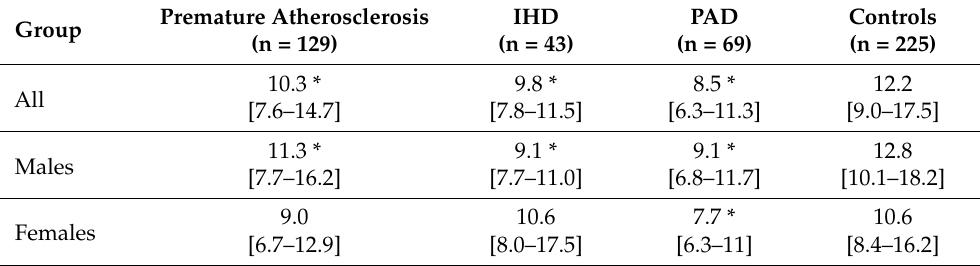
Table 1. Serum bilirubin concentrations in patients with various forms of atherosclerosis.